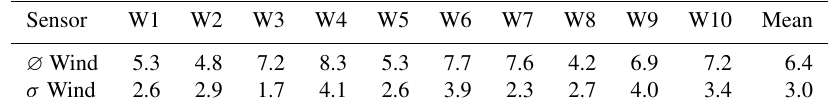
Table 2. Means and standard deviations of wind speed [ms − 1 ] at the ultrasonic anemometers for the 11d period in August 2021. Sensor W1 W2 W3